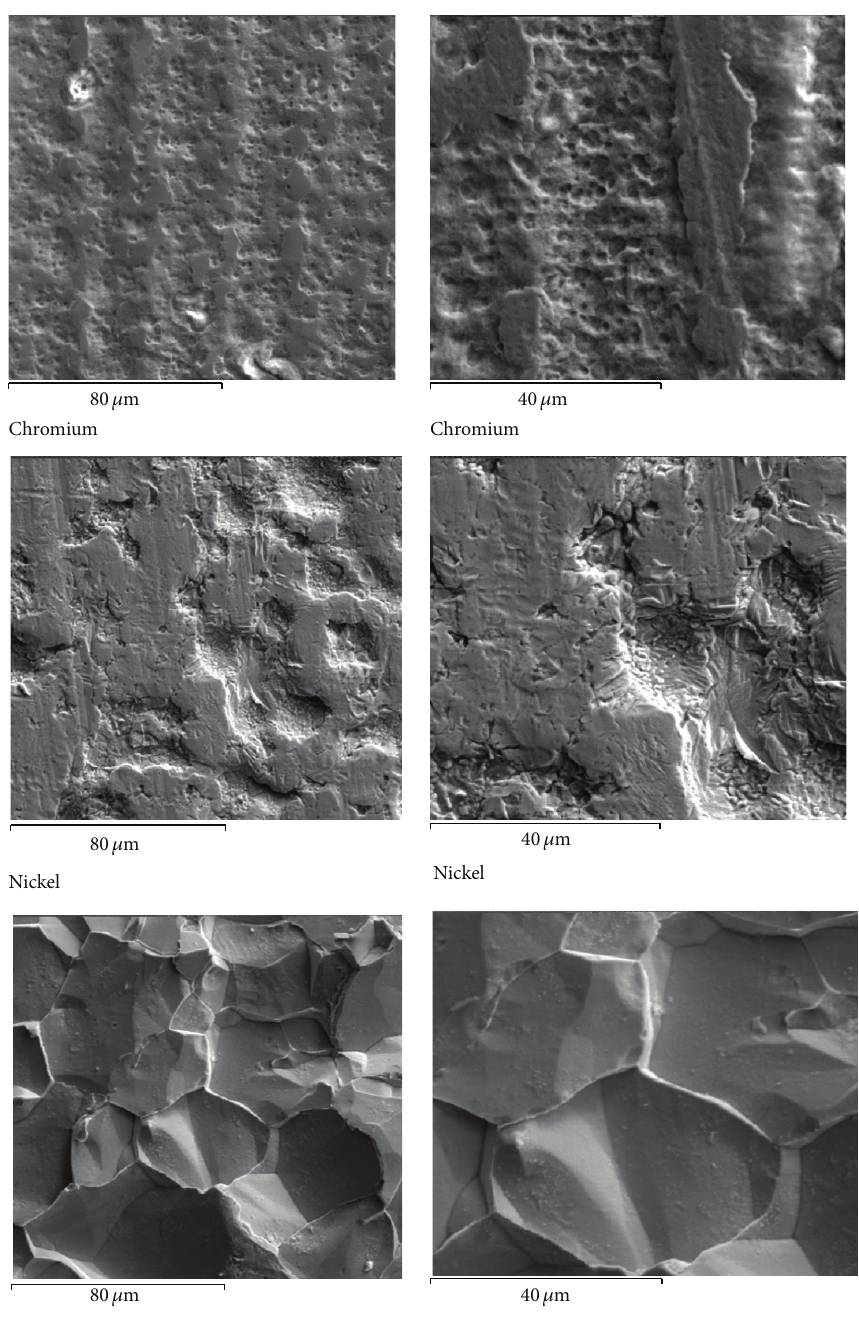
Figure 1: Micrographs of the cleaned pure chromium, pure nickel, and pure iron after being exposed to NaVO 3 for 100 hours at 700 ∘ C.